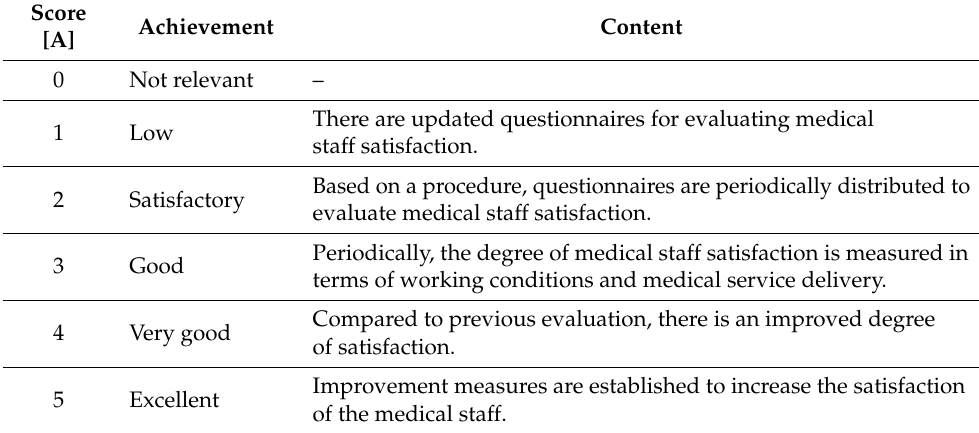
Table A14. Scale for indicatorEB3—Medical staff satisfaction.